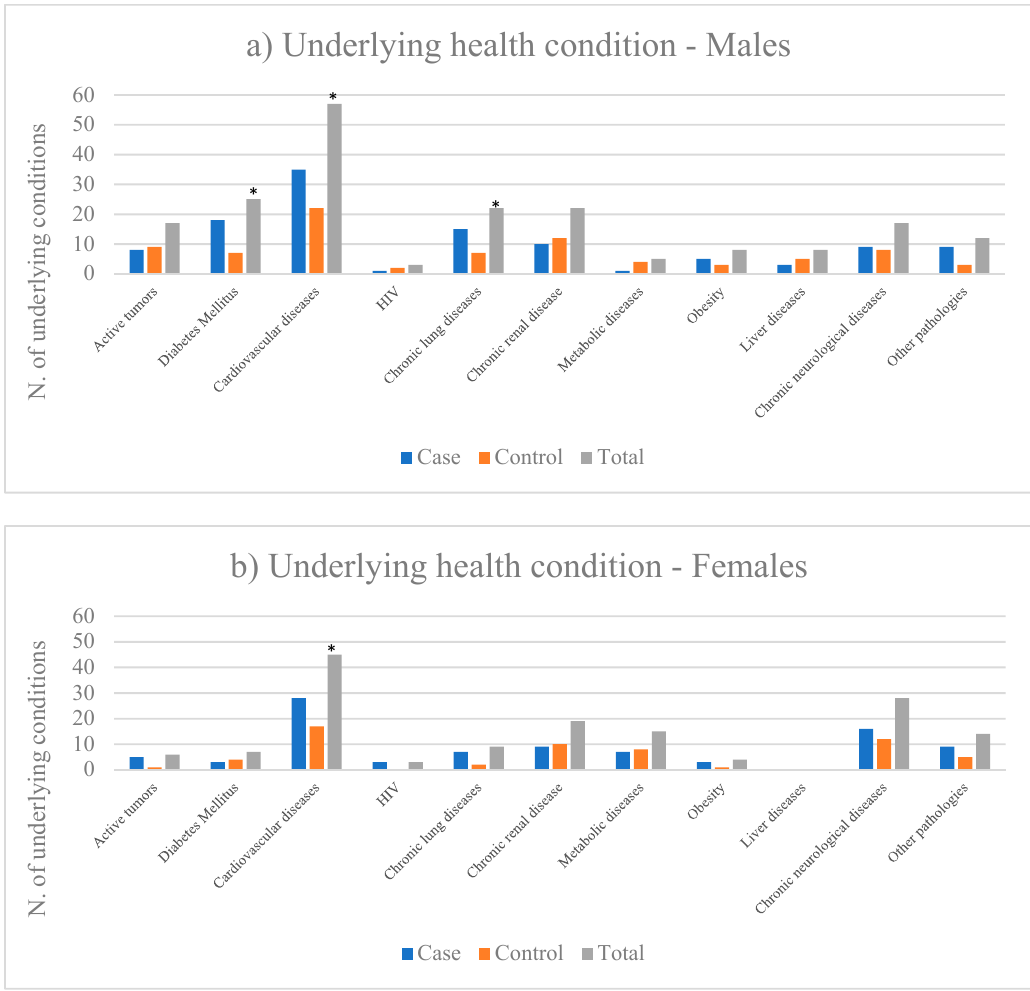
Figure 3. Case control study: underlying health conditions in both male (a) and female (b) cases deceased with SASRS-Cov-2 and paired controls. * p -value < 0.05.